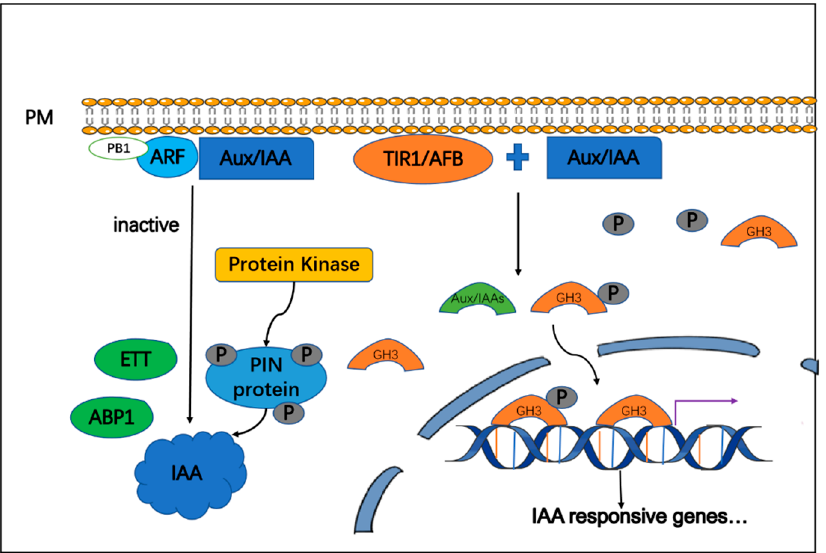
Figure 3. IAA signaling pathway from IAA perception to action. After receiving the IAA signal, the interaction between the three protein families of auxin and key components promotes the production of up-regulated gene encoding GH3 protein to activate the downstream IAA signal.